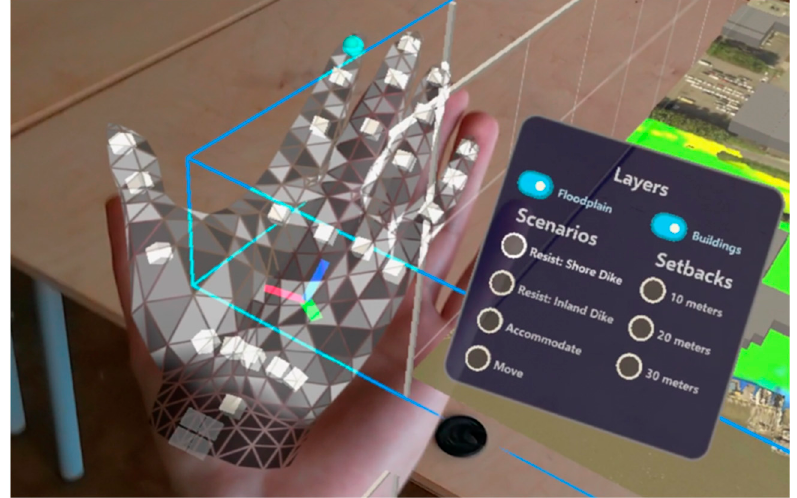
Figure 7. Screenshot of a single user application in use, with the content menu activated by bringing up the palm. You can see the hand mesh visualization, providing visual feedback to the user. Note: the significant displacement/difference between virtual and real hand only appears on captured